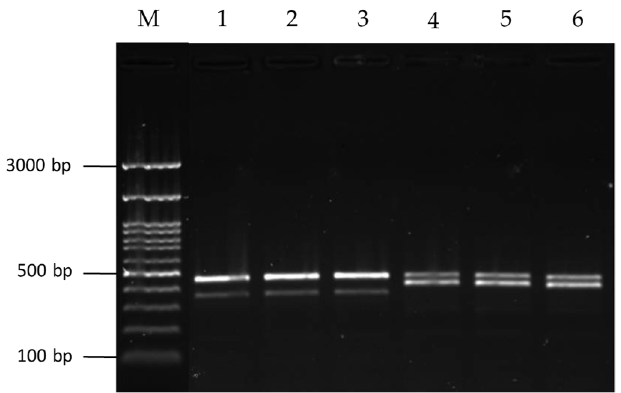
Figure 5. Agarose gel electrophoresis of PCR amplified trnH-psbA DNA barcode markers from the two mixed samples of Tulsi, TUL008 (lanes 1–3) and TUL015 (lanes 4–6), along with 100 bp DNA ladder (M).